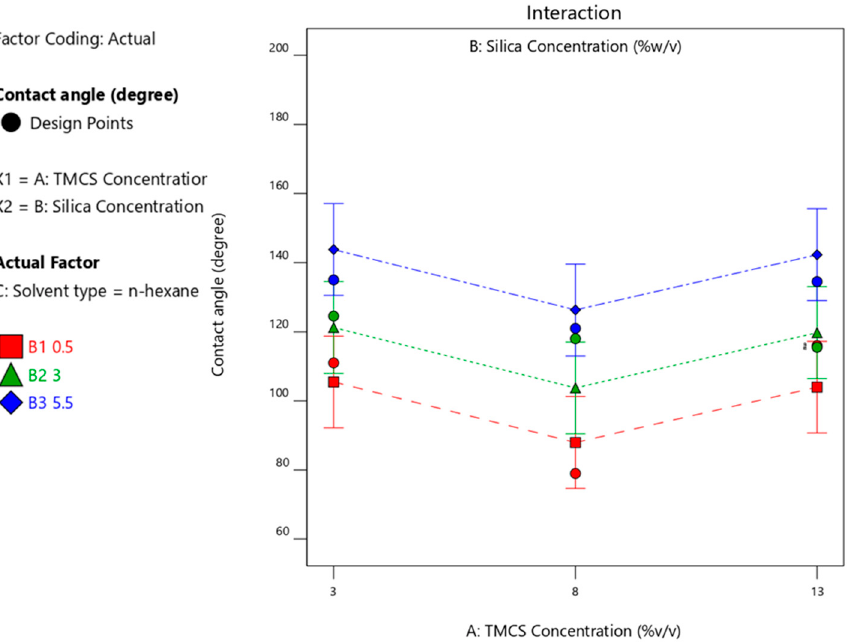
Figure 12. Contact angle upon interaction between TMCS and silica concentration with n-hexane solvent.